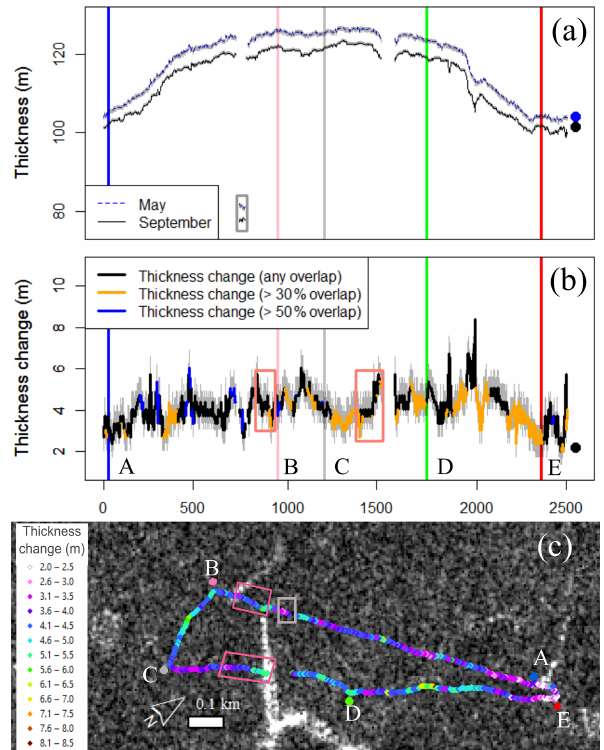
Figure 5. Spatial variation in morphology and thinning between May and September 2016. Upper-case letters are used to denote transect segments referred to in the text. (a) Thickness observa- tions collected with mobile ice-penetrating radar. The grey box cor- responds with the thin ice section also denoted in (c) . (b) Thick- ness change. The pink boxes indicate thickness change gradients also identified in (c) . Thinning data were categorized based on the amount of overlap between the May and September radar foot- prints. Grey shading in (a) and (b) denotes uncertainty in thick- ness measurements and thinning amounts, respectively. The larger, single points denote the respective thickness and thinning mea- sured with corresponding data collected by the sIPR at the main site. (c) Thickness change displayed on a Fine Quad RADARSAT- 2 synthetic aperture radar scene acquired on 28 September 2016 (shown in greyscale). A surface feature is apparent as a line of high- backscatter (white) pixels starting at the sidewall notch. The geolo- cation error of the RADARSAT-2 scene was evaluated, and minimal error in the position of the scene was